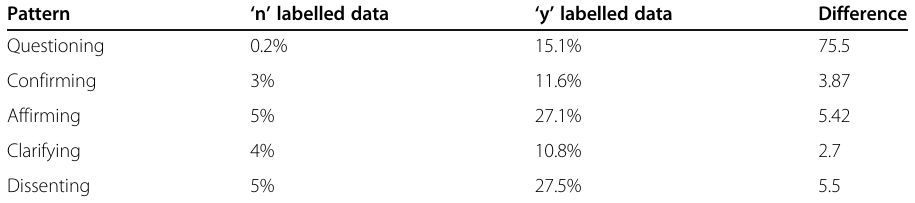
Table 5 Doubt sentic pattern distribution on both training and testing data ( ‘ n ’ is data labelled as having no doubt and ‘ y ’ as having doubt ) Pattern ‘ n ’ labelled data ‘ y ’ labelled data Difference Questioning 0.2% Confirming Affirming Clarifying